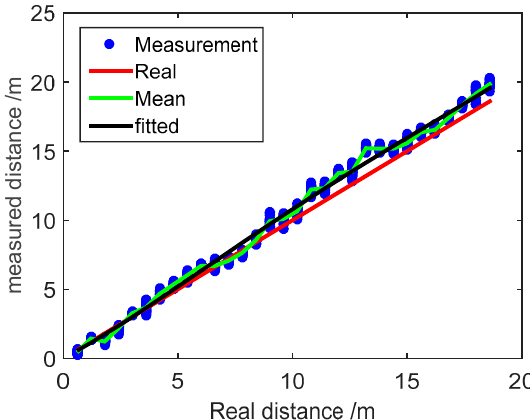
Figure 3. Measured distance values with WSN. Micromachines 2016 , 7 , 197